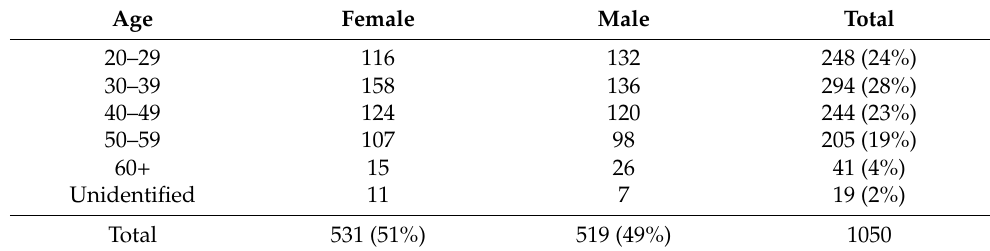
Table 5. Participant demographic information.